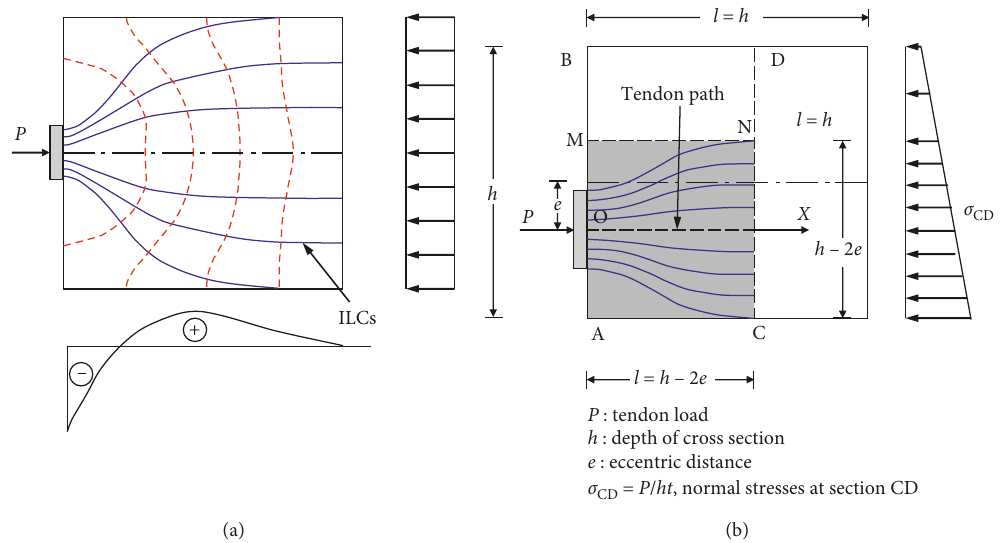
Figure 2: Isostatic lines of compression (reproduced from Guyon [2], under the Creative Commons Attribution license/public domain). (a) Centric and (b) eccentric.